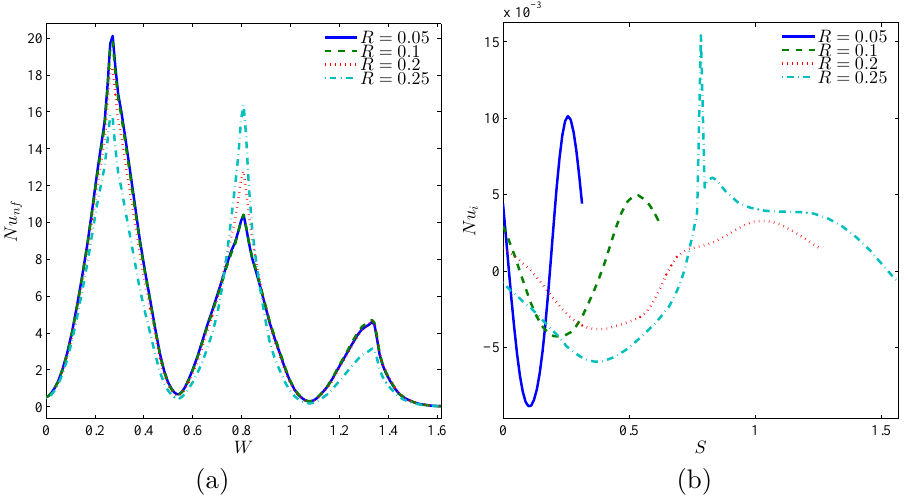
Figure 17. Variations of local Nusselt number interfaces with ( a ) W and ( b ) S for different R at Case 1 ( Ω ), Ri = 10, φ = 0.02, and N = 3.